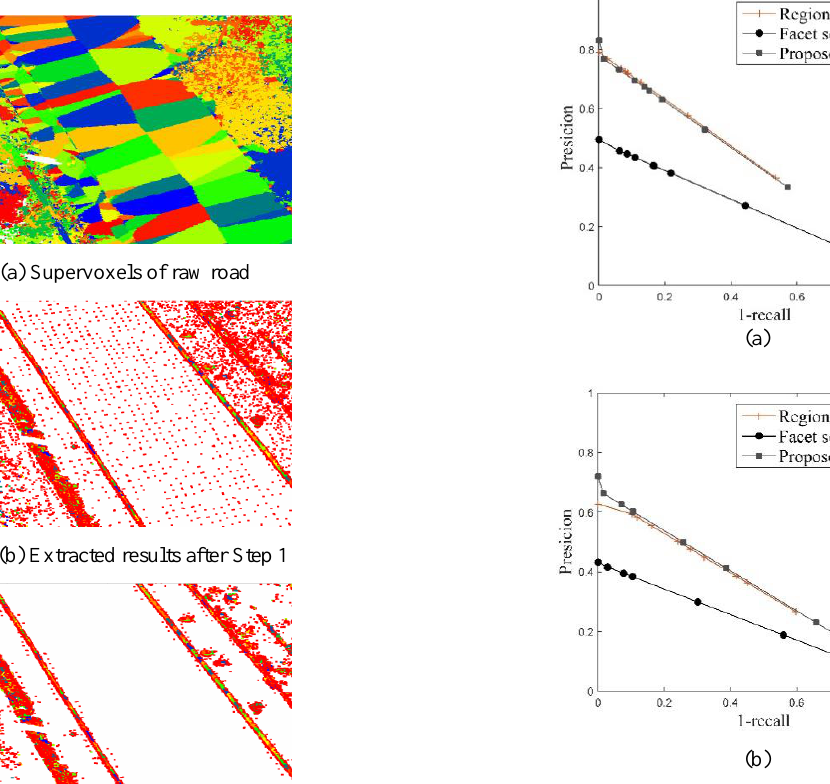
Figure 11. PR (precision-recall) curves of quantitative analysis in three different contour extraction methods on two MLS road data. (a) Road1, (b)